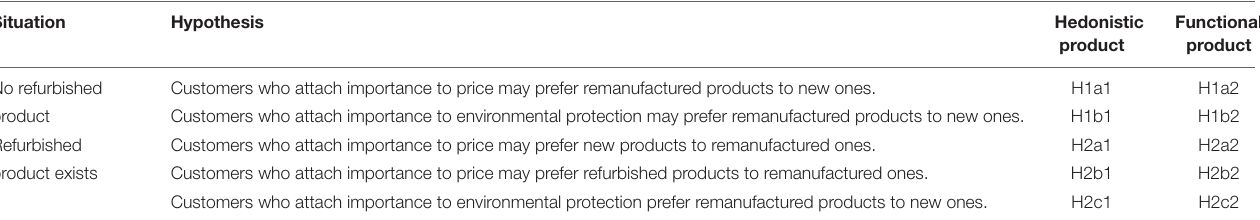
FIGURE 2 | Experimental flow. TABLE 1 | Hypothesis of consumer choice motivation.